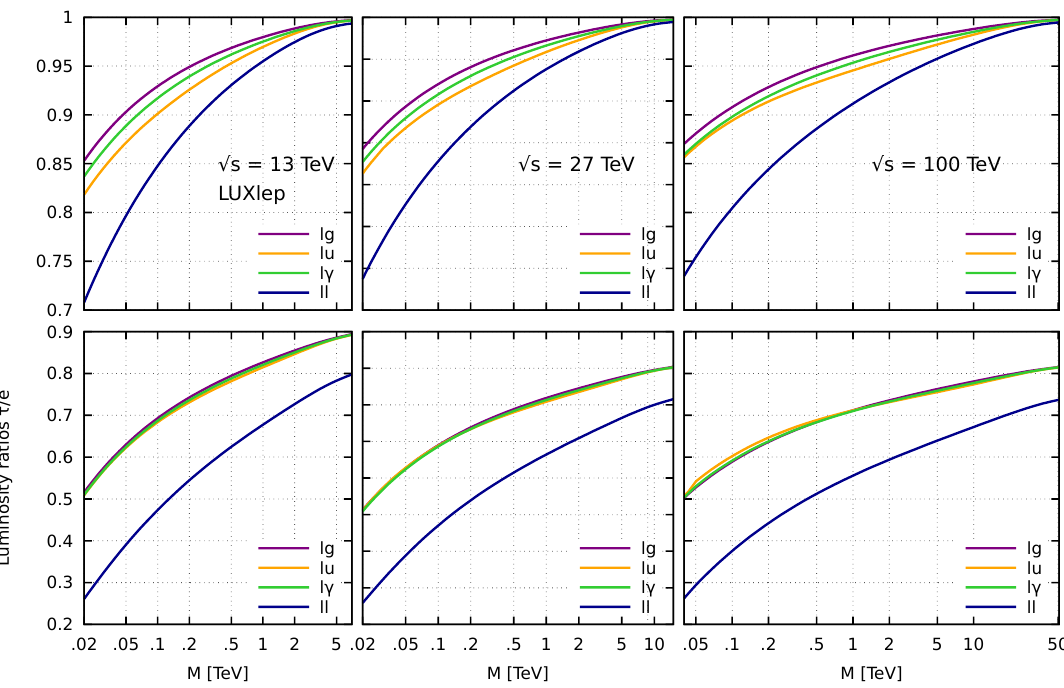
Figure 8. The ratio of the lepton-gluon ( lg , purple), photon-photon ( (cid:13)(cid:13) , red), lepton-up ( lu , orange), lepton-photon ( l(cid:13) , green), and lepton-lepton ( ll , blue) luminosities involving muons (upper panels) or taus (bottom panels) to the same luminosities involving electrons, at 13 TeV (left), 27 TeV (center) and 100 TeV